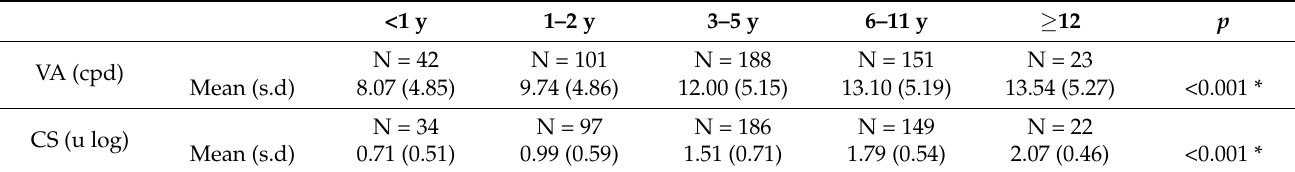
Table 4. AV and CS results in the Pre group, according to age